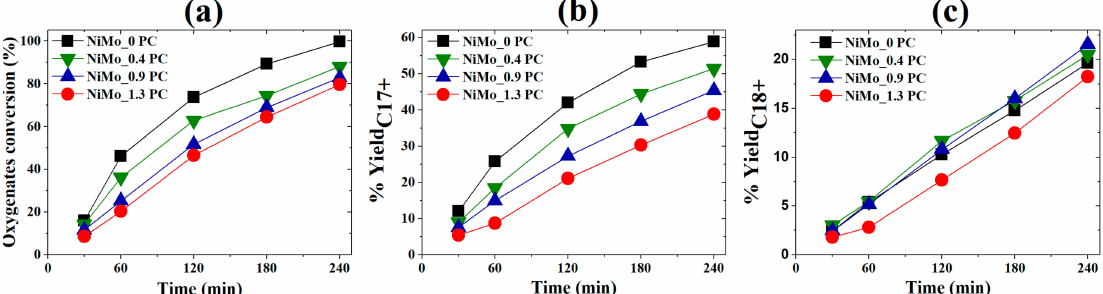
Figure 2. Effect of phospholipid (PC) on the HDO of oleic acid at 54 bar and 320 ◦ C using 0.3 mL DMDS; ( a ) oxygenates conversion, ( b ) yield of C17+, and ( c ) yield of